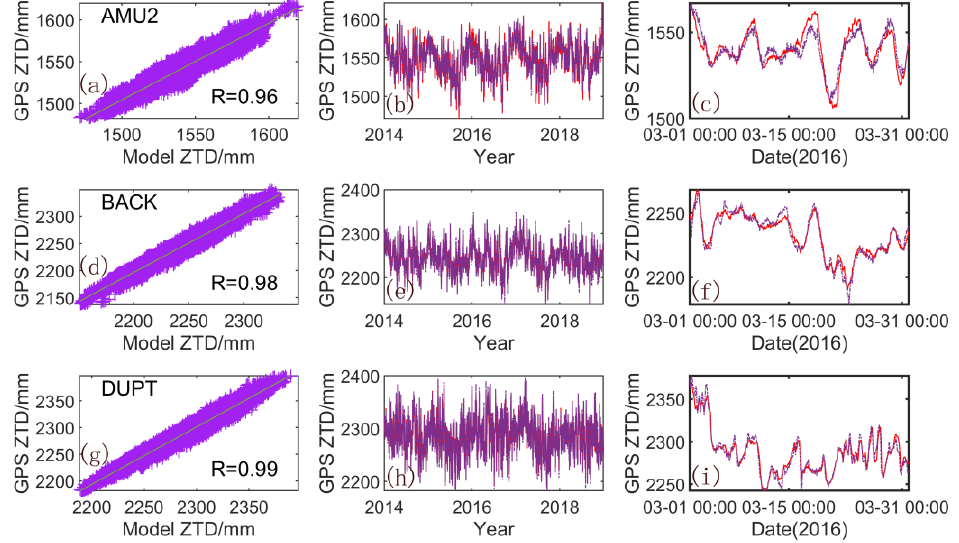
Figure 8. Comparison of GPS-ZTD and ICA-ZTD for the AMU2, BACK, and DUPT stations. ( a , d , g ) are correlation between the GPS-ZTD and ICA-ZTD; ( b , e , h ) are their time series from 2014 to 2018; ( c , f , i ) are time series in one month. Red solid line: PCA-ZTD; purple solid line: GPS-ZTD.